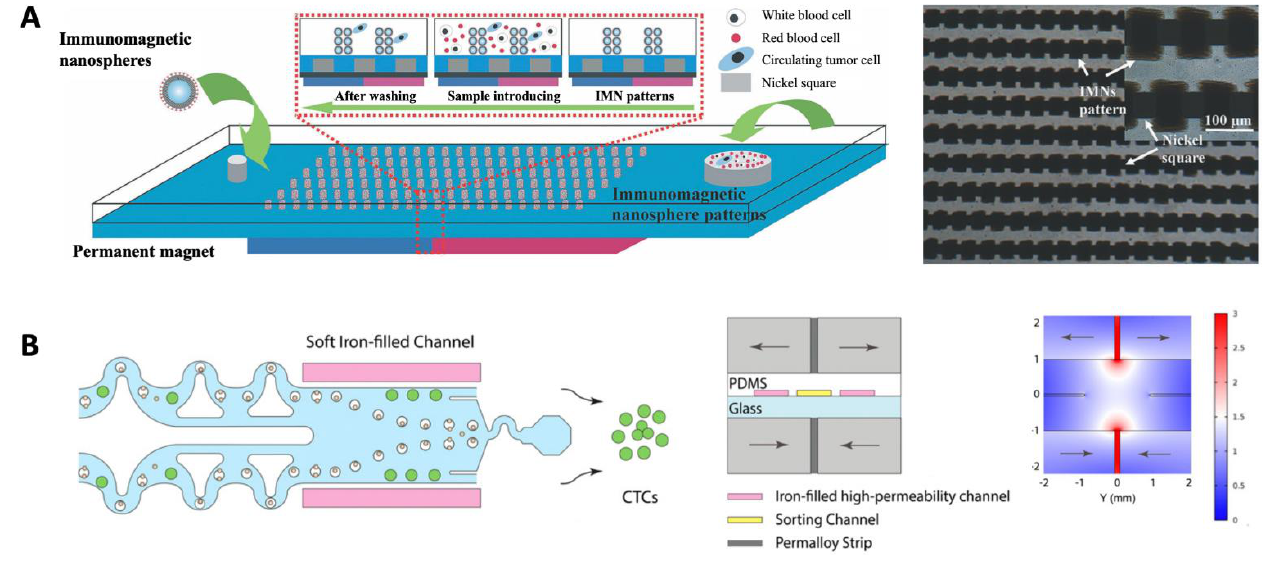
Figure 19. Microfluidic devices for CTC isolation. ( A ) Schematic diagram of magnetic nanosphere based microfluidic device and microscopic image of IMN patterns and Ni squares in the detection zone. Used with permission of Royal Chemical Society from [237]; permission conveyed through Copyright Clearance Center, Inc. ( B ) Final separation stage of the LP CTC-iCHIP, combining a wiggler concentrator for inertial focusing and a magnetic separator (top and cross views). The labeled WBCs are focused by the force towards the center of the channel, where the magnetic field intensity is maximum (right). Reprinted with permission from [171].